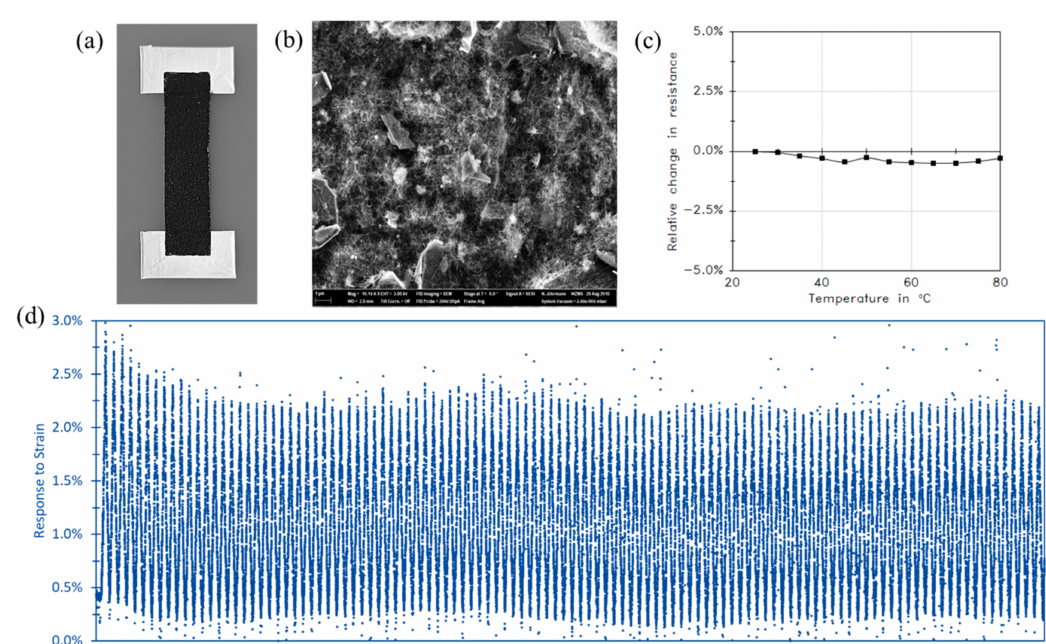
Figure 13. Thin film CNT-graphene hybrid nanocomposite-based temperature self-compensated strain sensor. ( a ) Photo- graph of the hybrid nanocomposite, ( b ) SEM image of the CNT-graphene nanocomposite, ( c ) relative change in resistance of the CNT-graphene hybrid nanocomposite between 20 and 80 ◦ C and ( d ) Response of the hybrid sample under cyclic strain loading